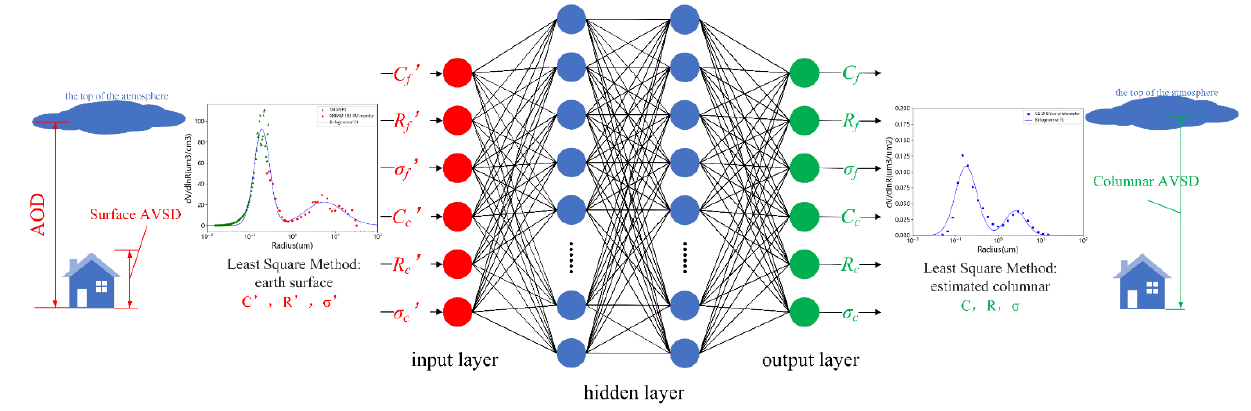
Figure 3. The BPNN (Back Propagation Neural Network) model. The red dots represent the input layer, whose input parameters are the six distribution parameters ( C f’ , C c’ , R f’ , R c’ , σ f’ , σ c’ ) of the surface AVSD (aerosol volume size distribution) obtained by least squares fitting; the blue dots represent the hidden layer, where the lines between different points represent their relationships and network weights; the green dots represent the output layer, whose output parameters are the six distribution parameters ( C f , C c , R f , R c , σ f , σ c ) of the columnar AVSD obtained by least squares fitting.